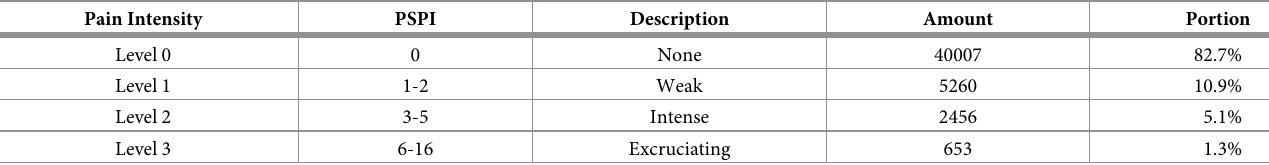
Table 3. The detailed sample distribution and number of different pain levels.